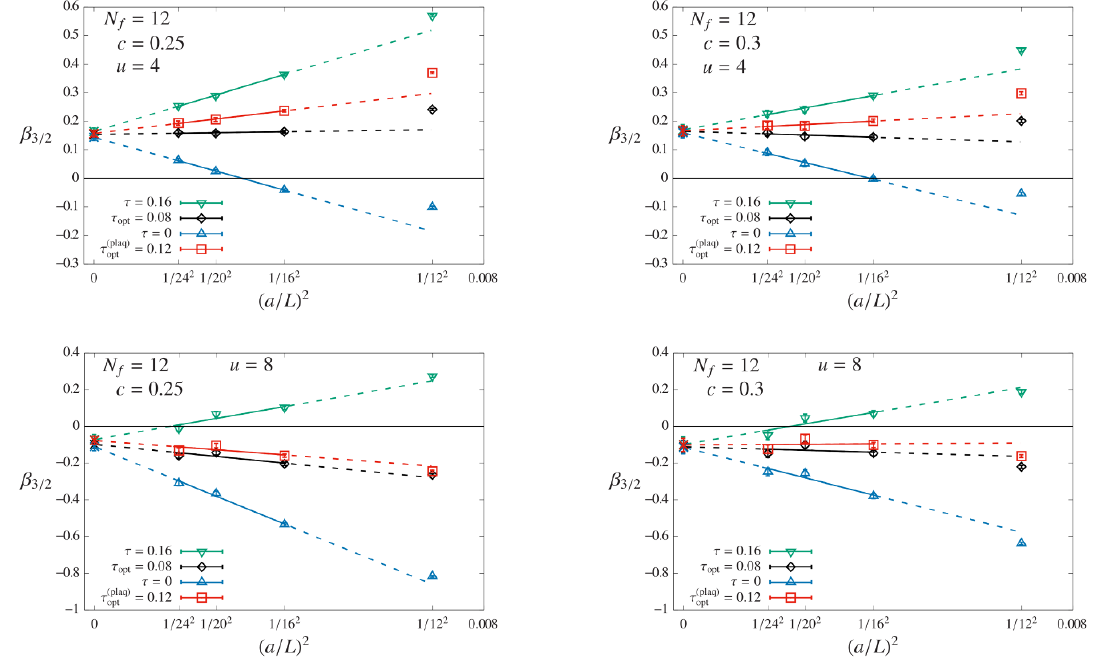
Figure 2 . Linear ( a=L ) 2 ! 0 extrapolations of the s = 3 = 2 discrete (cid:12) function for c = 0 : 25 (left) and 0.3 (right), at two values of u = 4 (top) and 8 (bottom) on either side of the IR (cid:12)xed point. In each plot we compare (cid:28) 0 = 0 and 0.16 to the optimal (cid:28) opt = 0 : 08, and also include results from the plaquette discretization of the energy density E ( t ) in eq. (2.3) at the corresponding optimal (cid:28) (plaq) = 0 : 12. As required, all di(cid:11)erent (cid:28) 0 produce extrapolations to consistent values in opt the ( a=L ) 2 ! 0 limit. Only L (cid:21) 16 are included in the (cid:12)ts, though L = 12 ! 18 points are shown for comparison. The bottom row of plots shows that restricting L (cid:21) 20 at u = 8 would produce ( a=L ) 2 ! 0 extrapolations farther below zero, reinforcing the existence of the IR (cid:12)xed